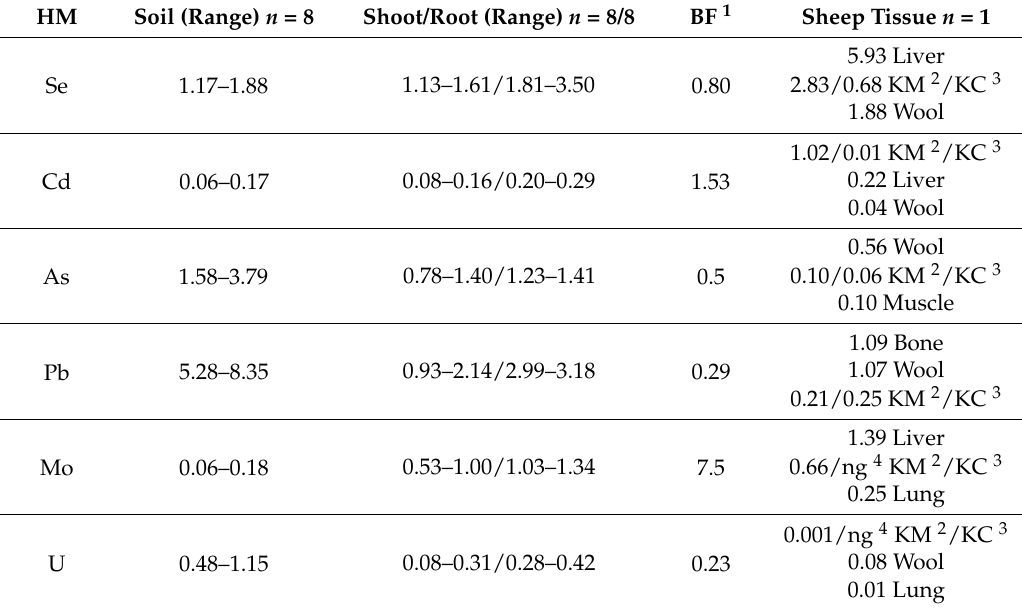
Table 4. Sheep 2 heavy metal concentrations in soil, forage, bioaccumulation factor ratio, and sheep tissue in mg/kg, dry